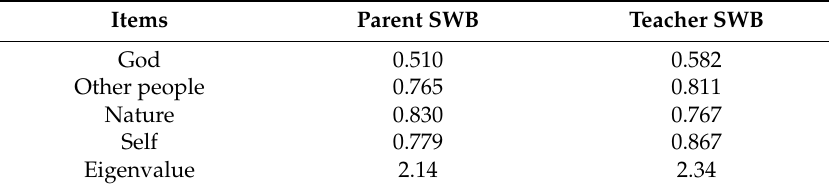
Table 2. Component matrices from Principal Components Analysis (PCA) for four items in SWB.